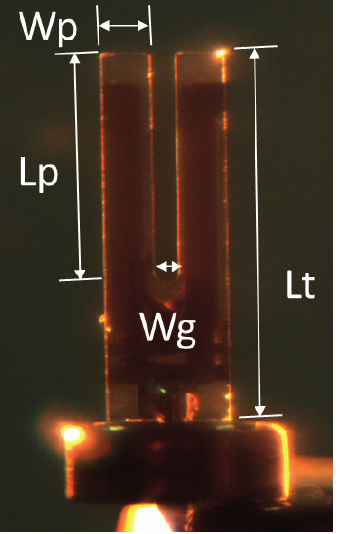
Figure 1. The geometry of a